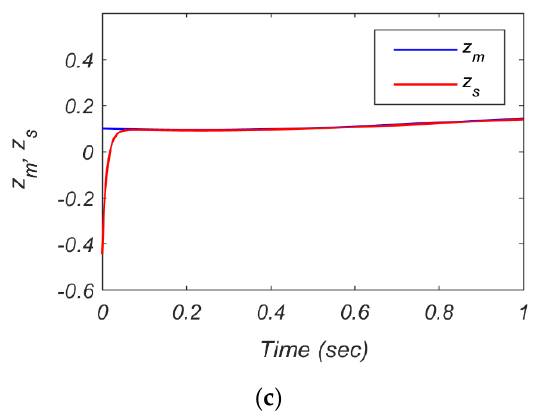
Figure 5. State variable synchronization of systems (10) and (11): ( a ) x m -x s ; ( b ) y m -y s ; ( c ) z m -z s .